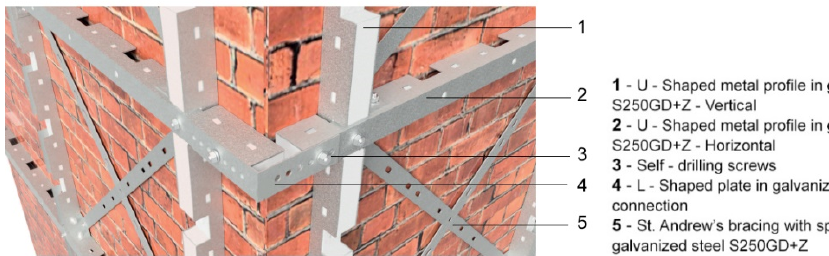
Figure 3. Connection between two adjacent U–shaped profiles.